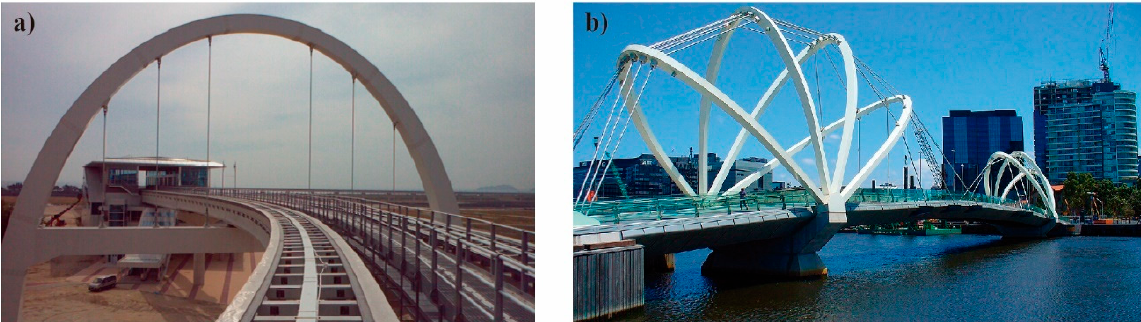
Figure 15. ( a ) Incheon Maglev Arch Bridge (photo: KO rail Engineer, flickr.com), and ( b ) Seafarers Bridge (photo: Ravi Kumar, Wikimedia Commons).